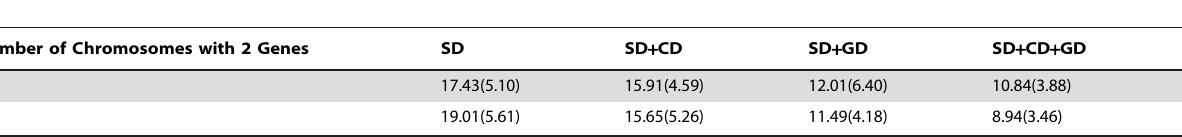
Table 3. Comparison of mean percentage reconstruction error (with standard deviation) of different phylogeny models on simulated data for two different probe